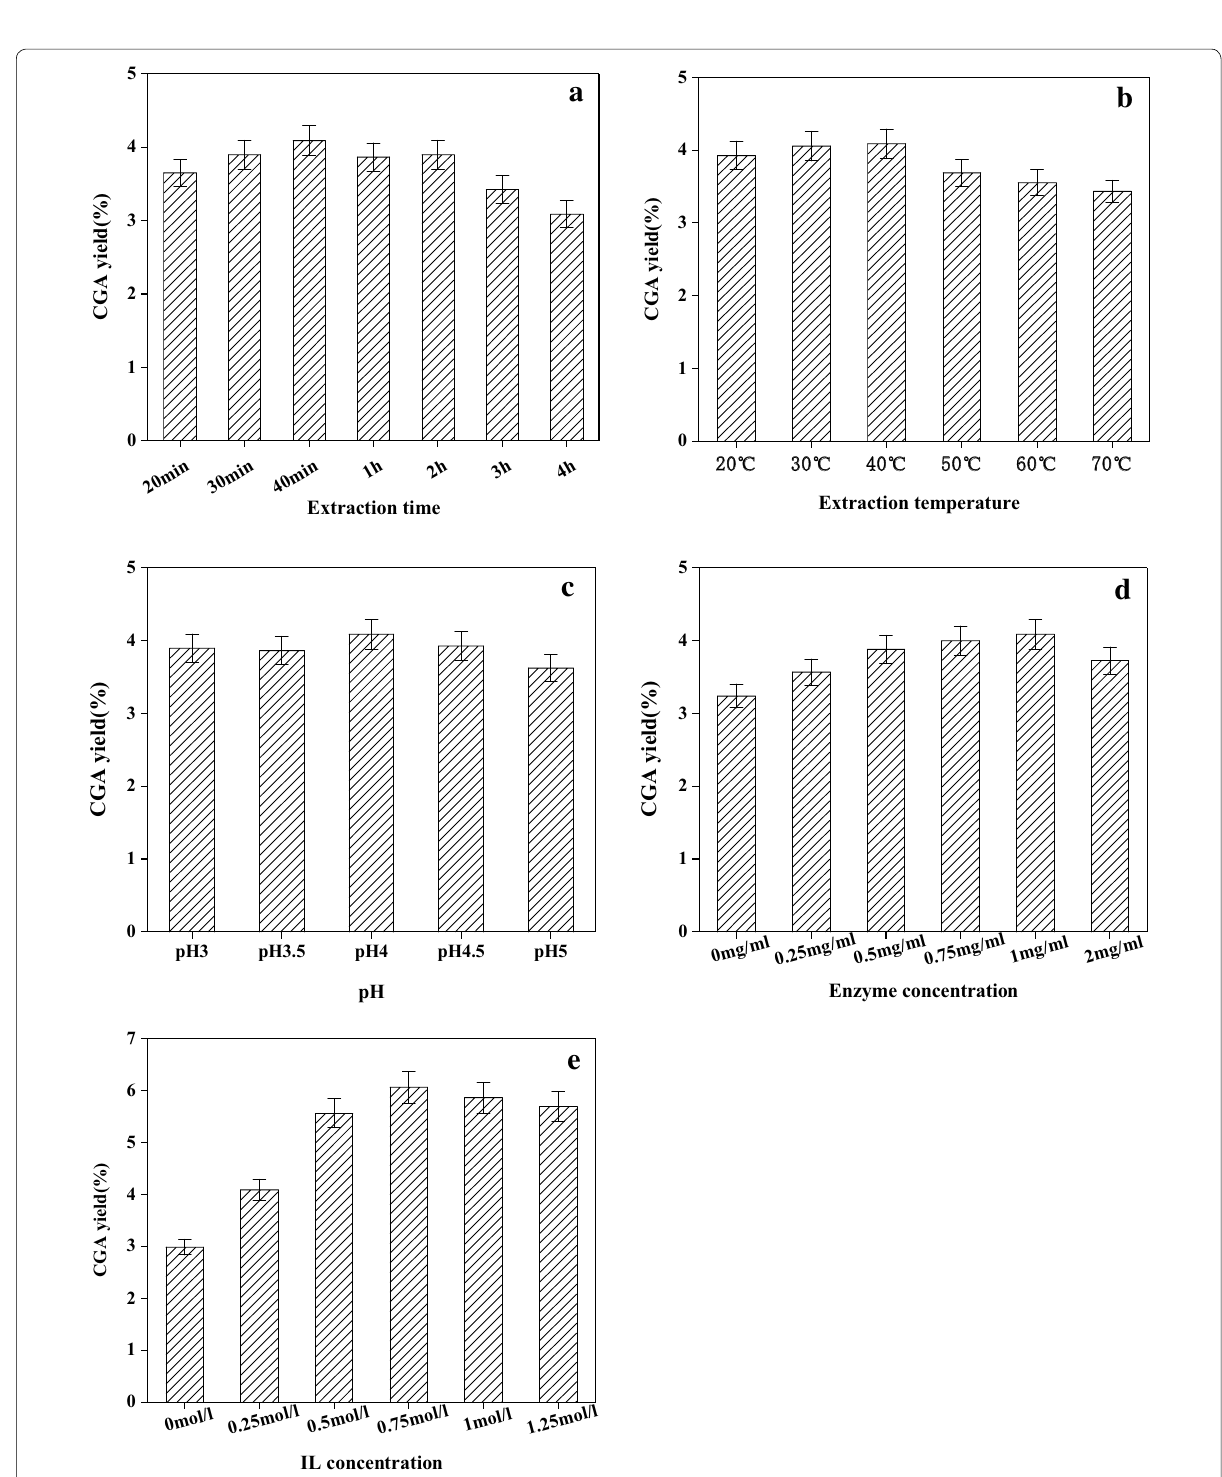
Fig. 3 Effects of extraction time ( a ), extraction temperature ( b ), pH ( c ), enzyme concentration ( d ), IL concentration ( e ) on the extraction yields